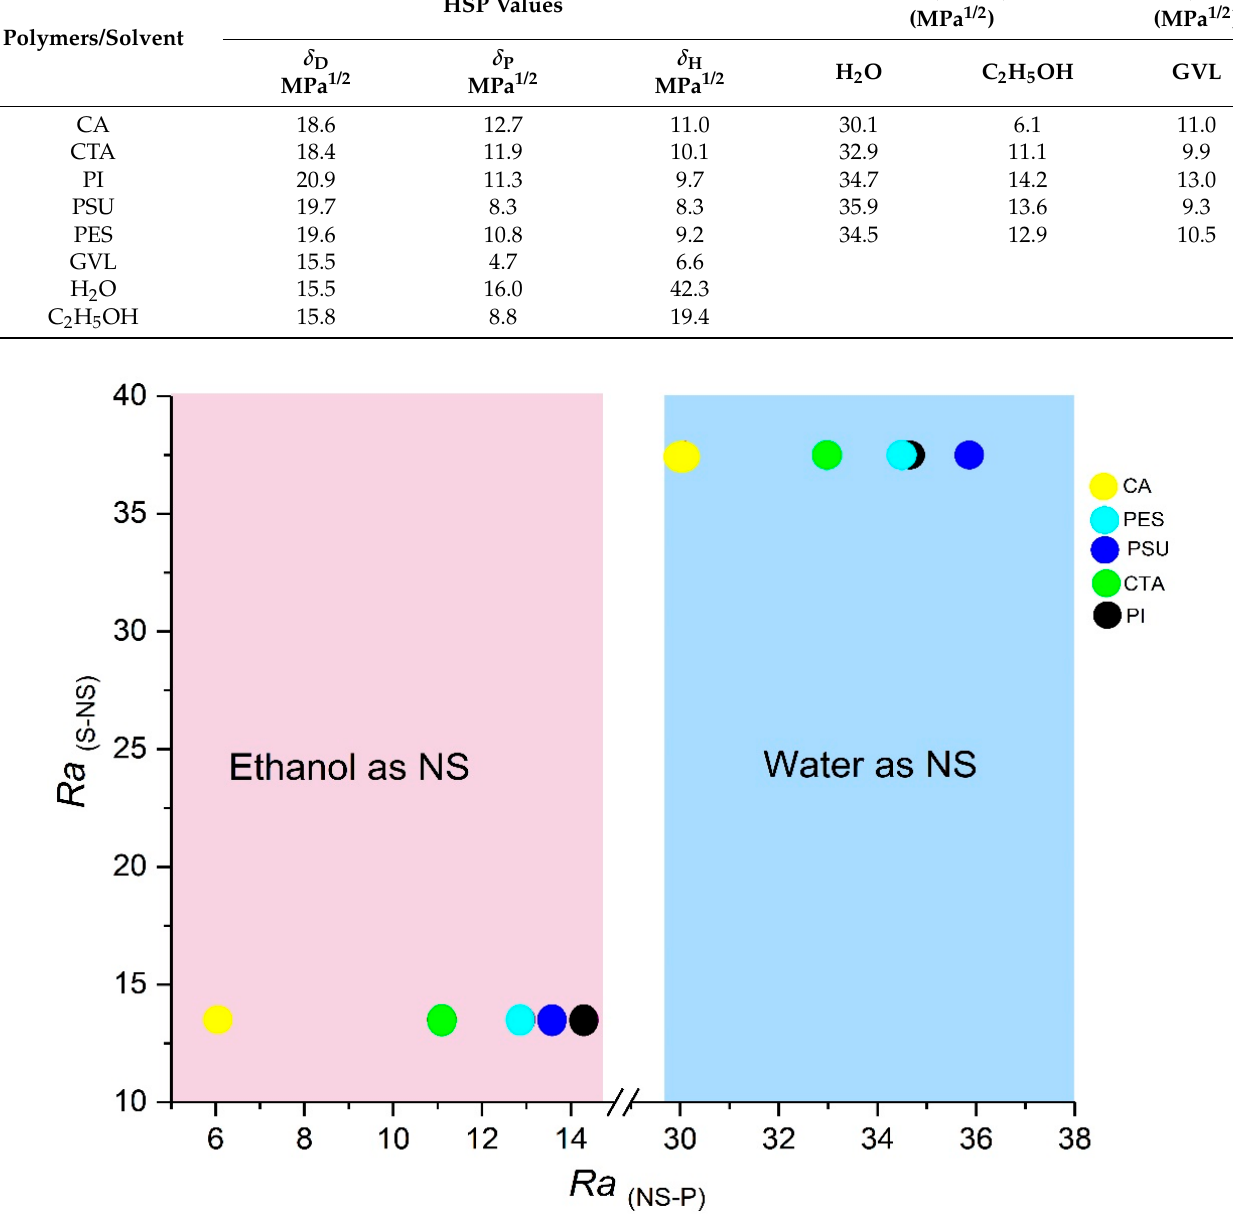
) vs. the interaction dis- (cid:3020)(cid:2879)(cid:3015)(cid:3020) ) . (cid:3015)(cid:3020)(cid:2879)(cid:3017)